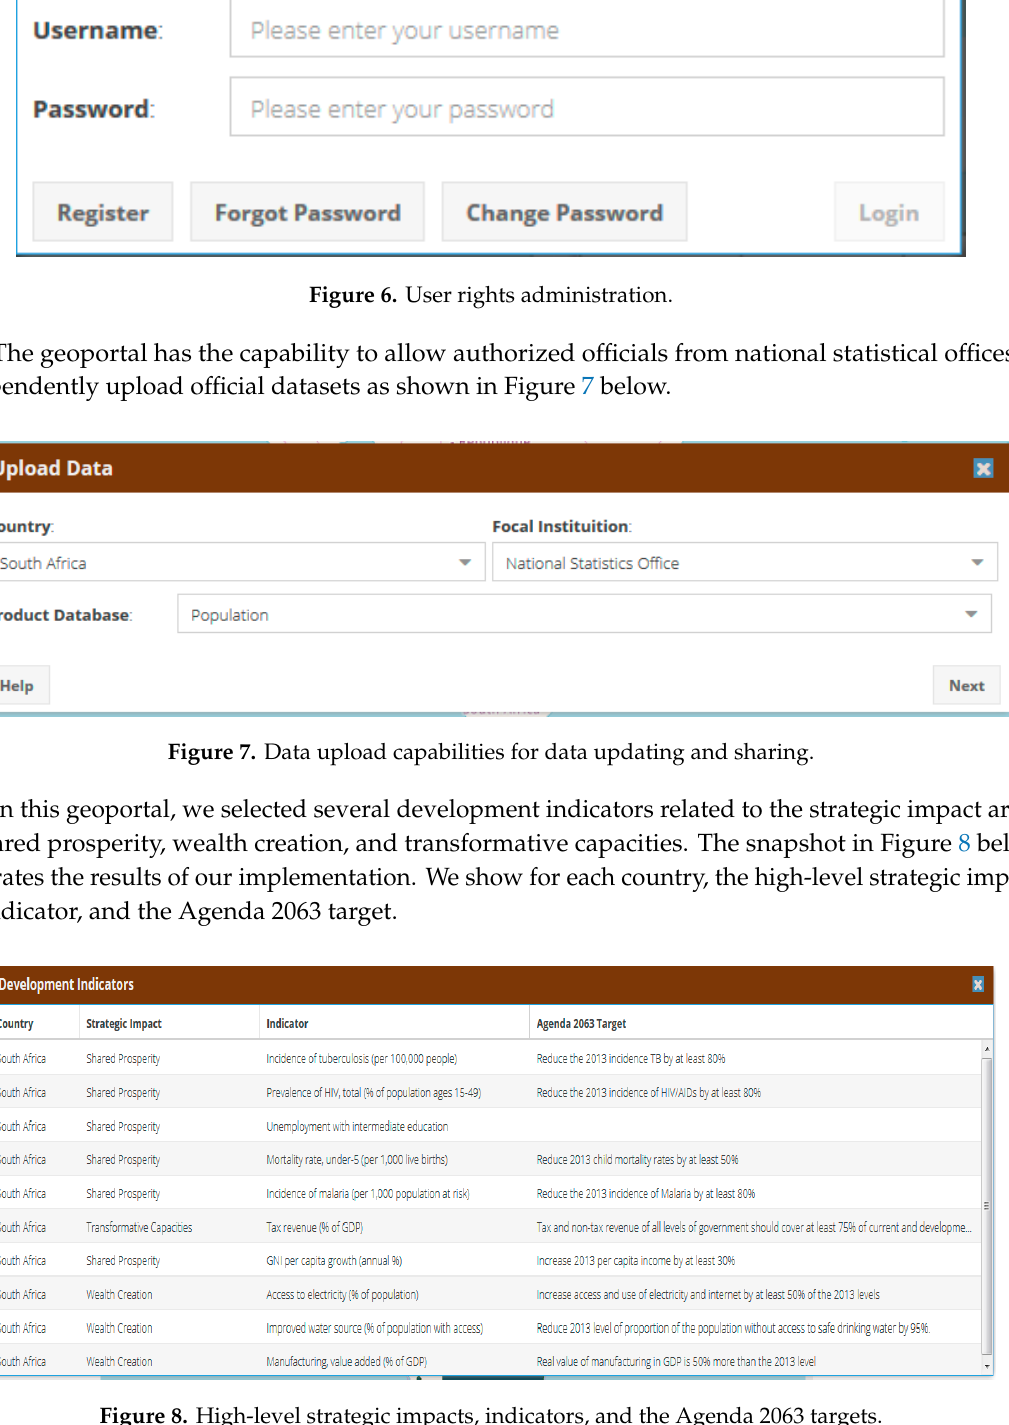
Figure 8. High-level strategic impacts, indicators, and the Agenda 2063 targets.